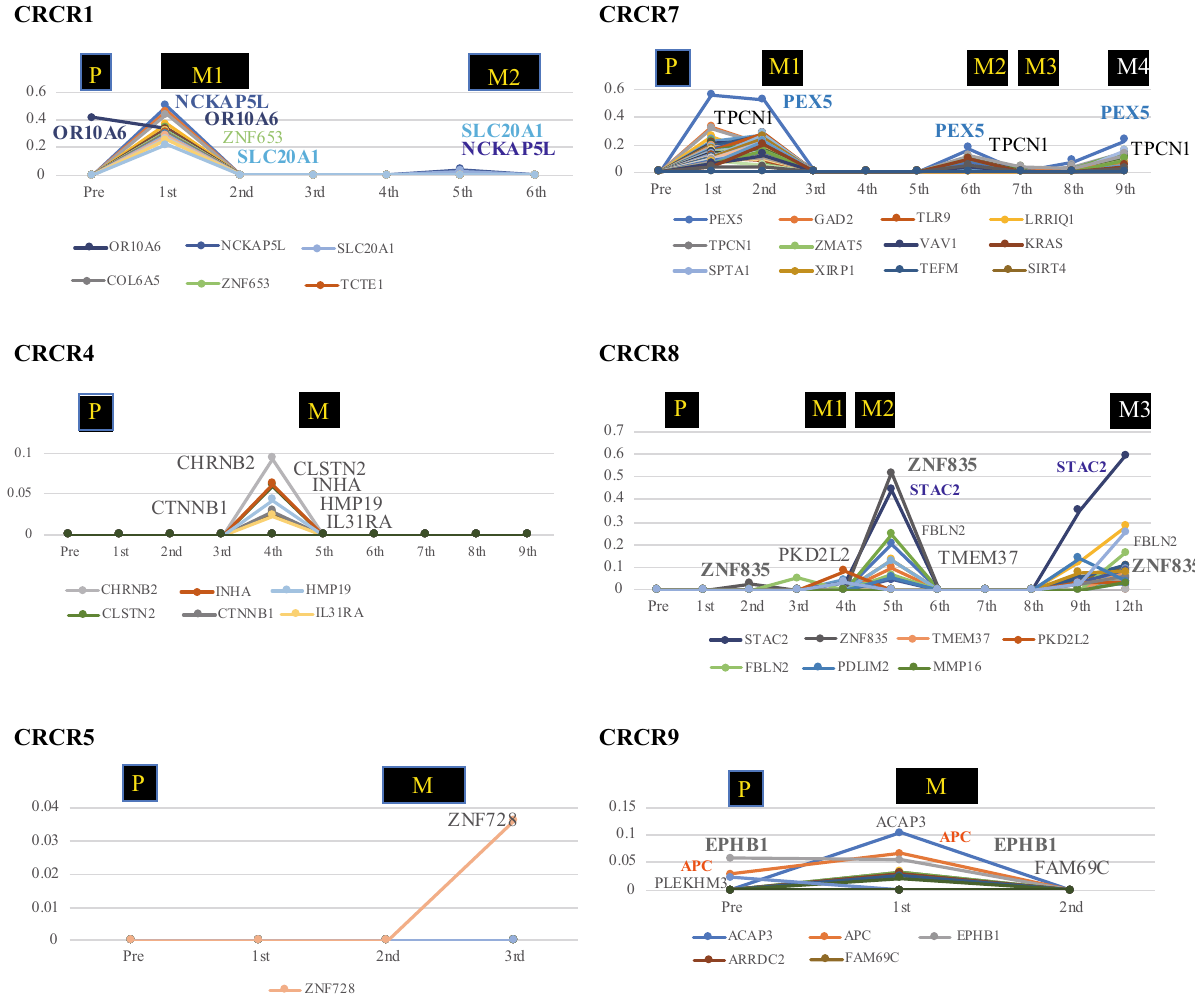
Figure 2. Alteration of mutation allele frequency of target genes. In CRCR1, NCKA5L and SLC20A showed mutations from M1 to M2, respectively. An OR10A6 mutation was detected preoperatively and at M1. In CRCR4, CTNNB1 , CHRNB2 , and CLST2 were frequently mutated in the M1 sample. In CRCR7, the MAFs of PEX5 and TPCN1 were detected multiple times with recurrent tumors. In CRCR8, STAC2 , ZNF835 , and FBLN2 were altered along with M2 and M4. In CRCR9, a higher MAF of EPHB1 was detected in preoperative and M1